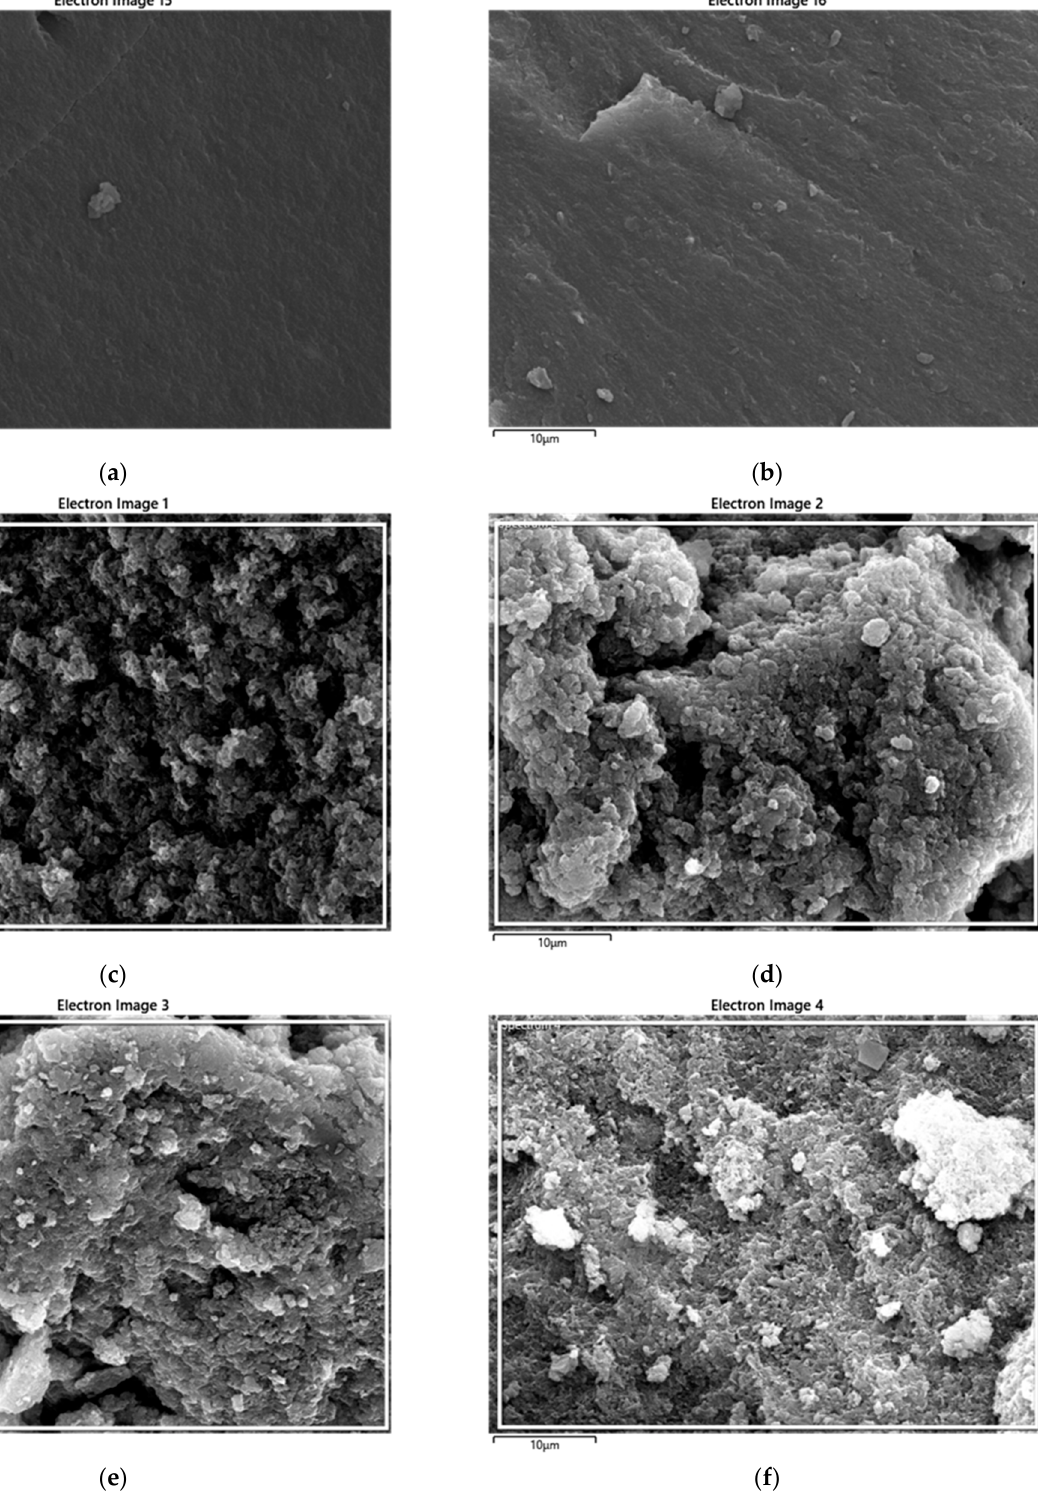
Figure 15. BSE images of PPS@BC nanocomposites: ( a ) PPS, ( b ) BSE PPS-2, ( c ) PPS-4, ( d ) PPS-6, ( e ) PPS-8, and ( f ) PPS-10.